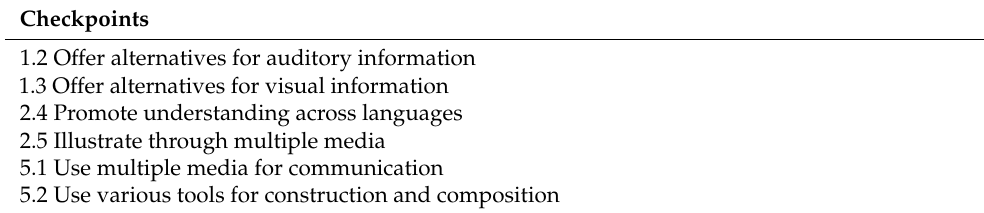
Table 6. Checkpoints suggested for